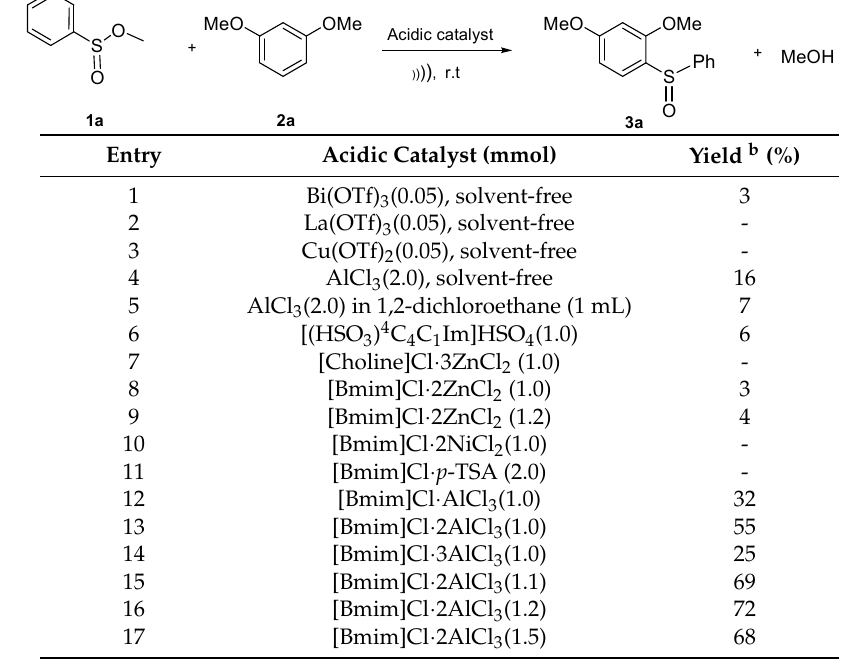
Table 1. Influence of the nature of the acidic catalyst on the formation of 2,4-dimethoxy-1-(phenylsulfinyl)benzene ( 3a ) a .